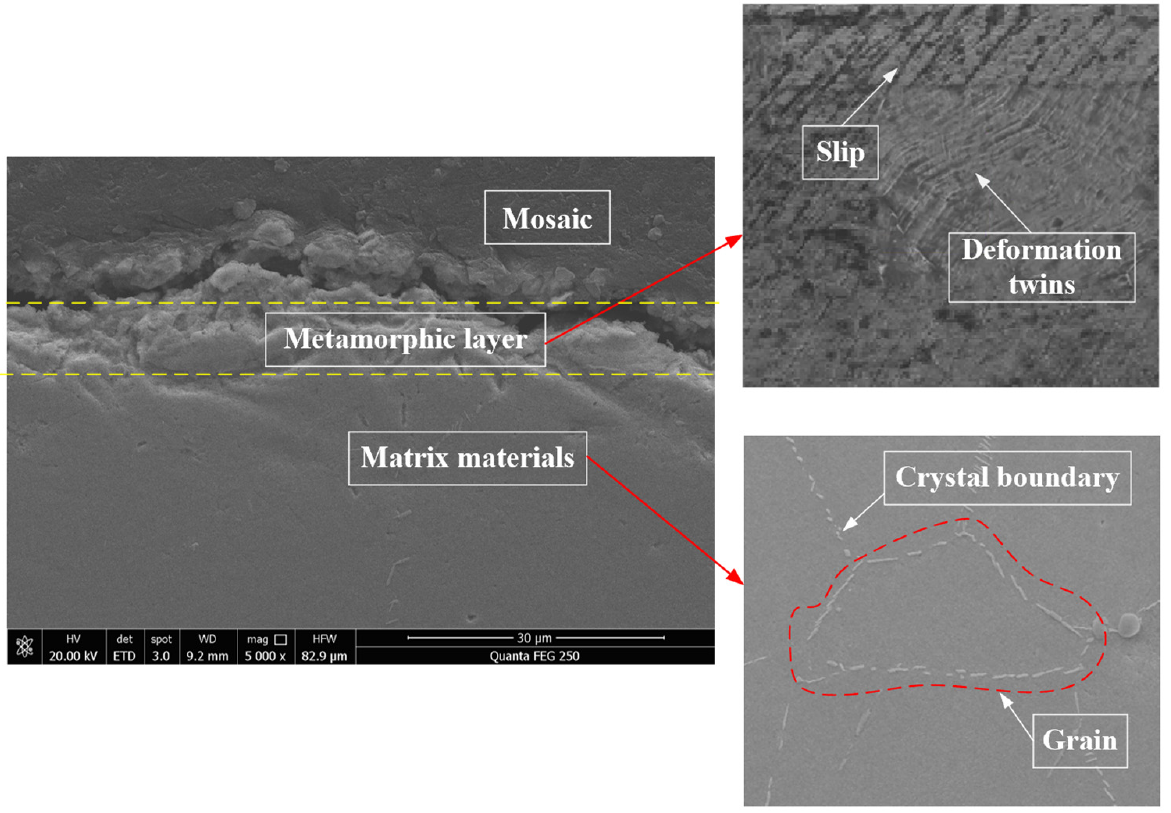
Figure 13. The cross-sectional microstructure of the GH4169 workpiece.